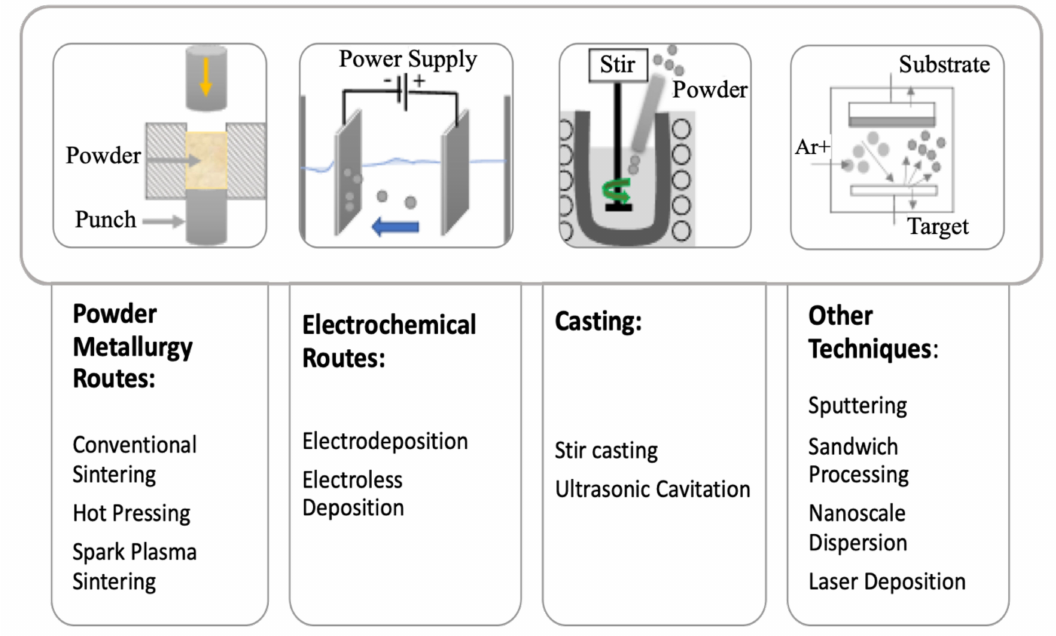
Figure 2. Main production techniques used for